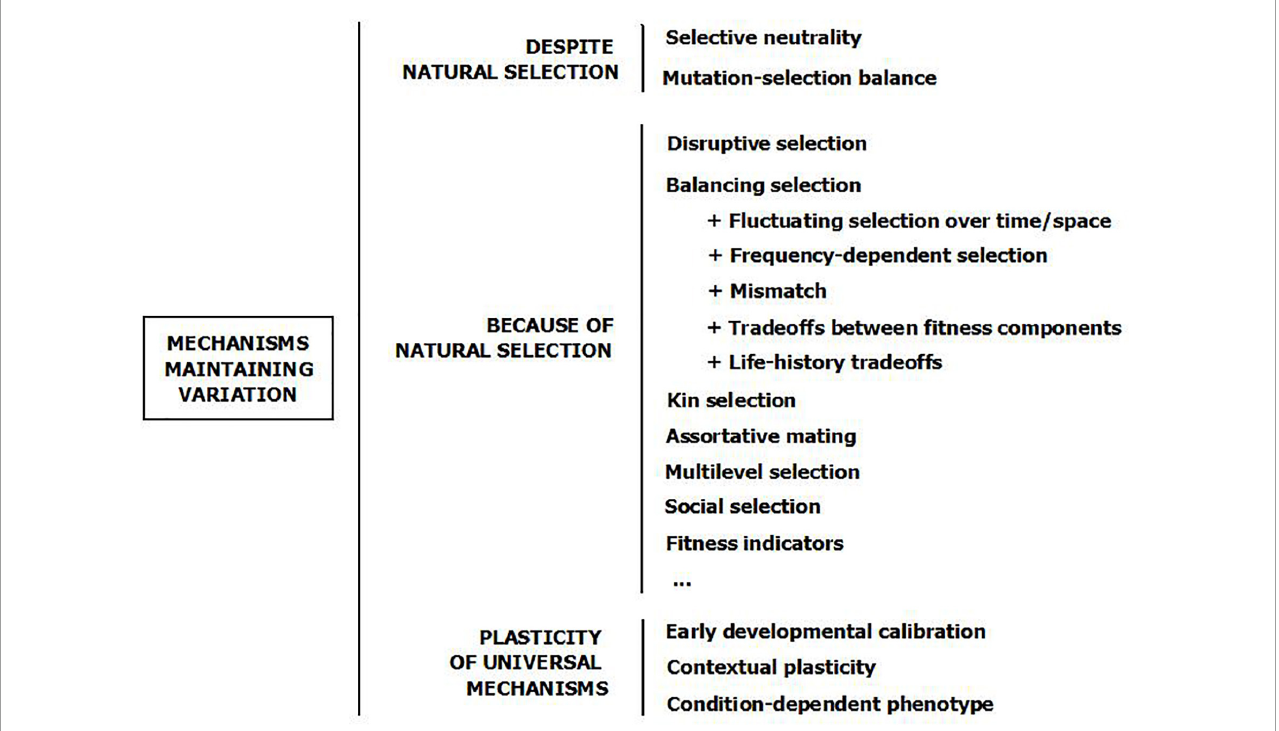
FIGURE3 Evolutionary mechanisms which are able to maintain variation in behavioral traits. The mechanisms are not mutually exclusive. The schema is based on (29, 44, 69, 156, 159,